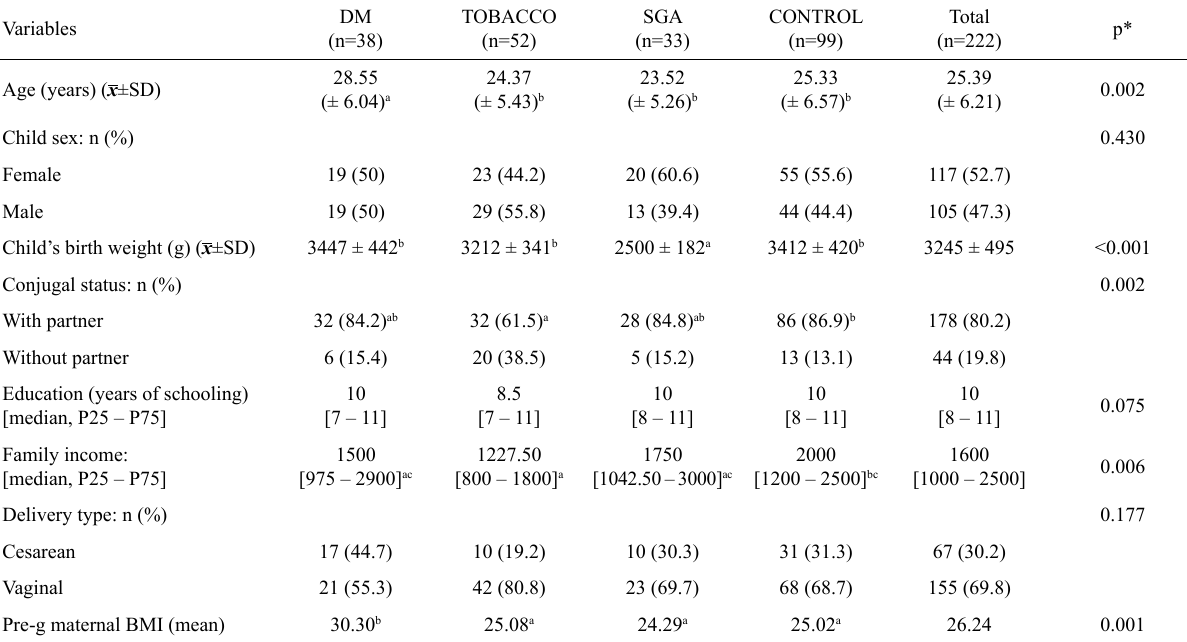
Table 1 ‒ Maternal and newborn characteristics among study groups.